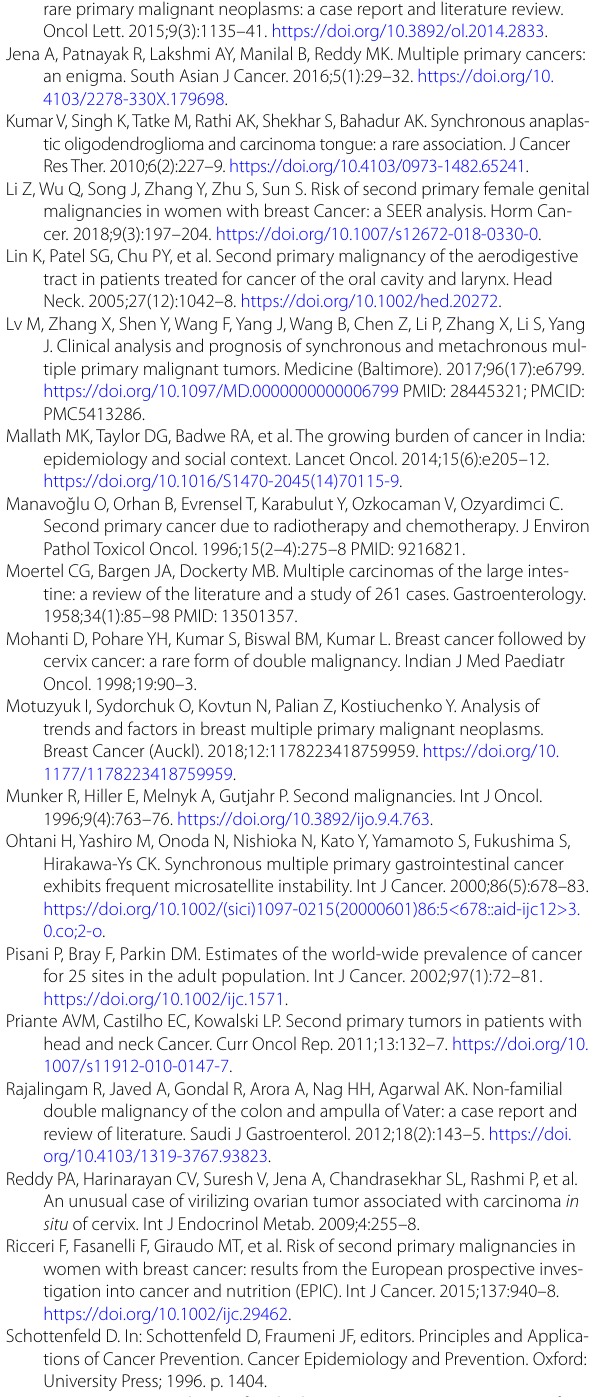
figur es- 2019- 2020. pdf. Chai H, Brown RE. Field effect in cancer-an update. Ann Clin Lab